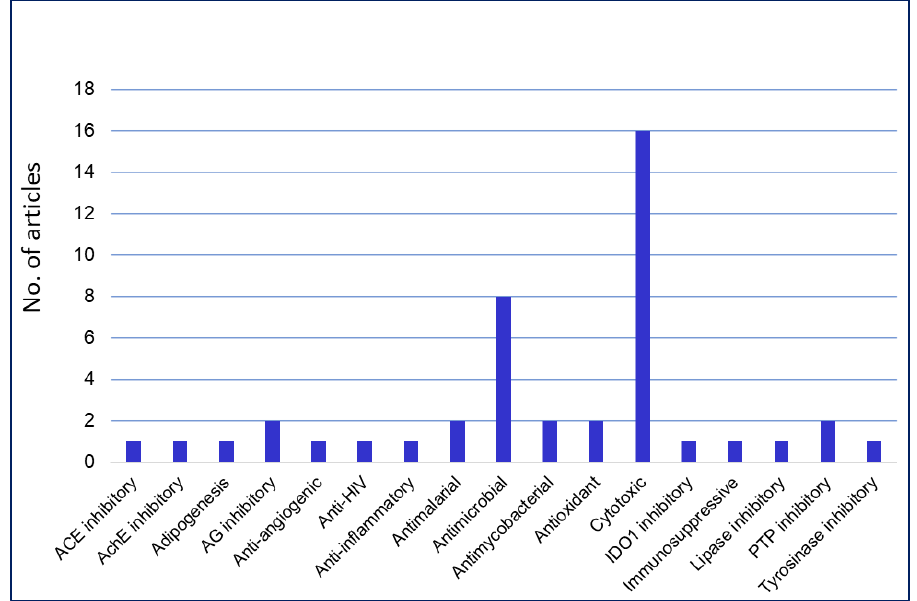
Figure 25. Biological activities of isolated phenalenones and the number of articles.